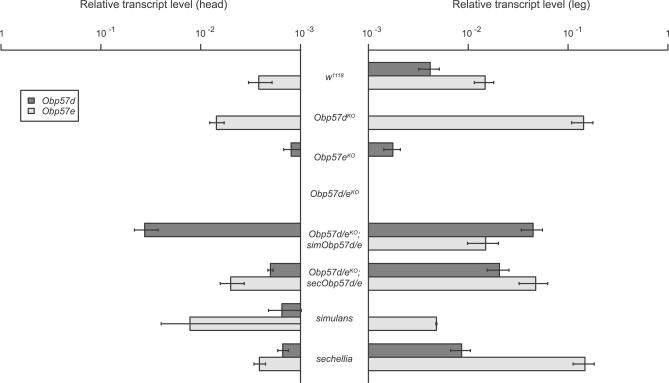
Quantitative RT-PCR Analysis of Obp57d and Obp57e TranscriptsHeads and legs from 20 staged females were used for analysis. Transcript level relative to that of the ribosomal protein gene rp49 is shown. Each bar represents the mean of three replicates. Error bars indicate standard error.